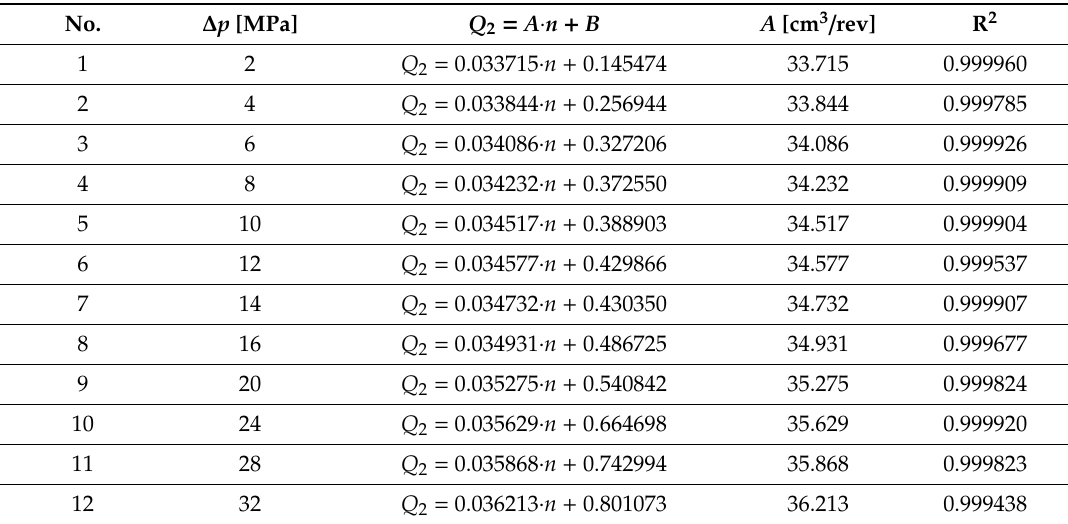
Table A2. Equations Q 2 = A · n + B of motor output flow rate at ∆ p = const. (Balawender’s method).